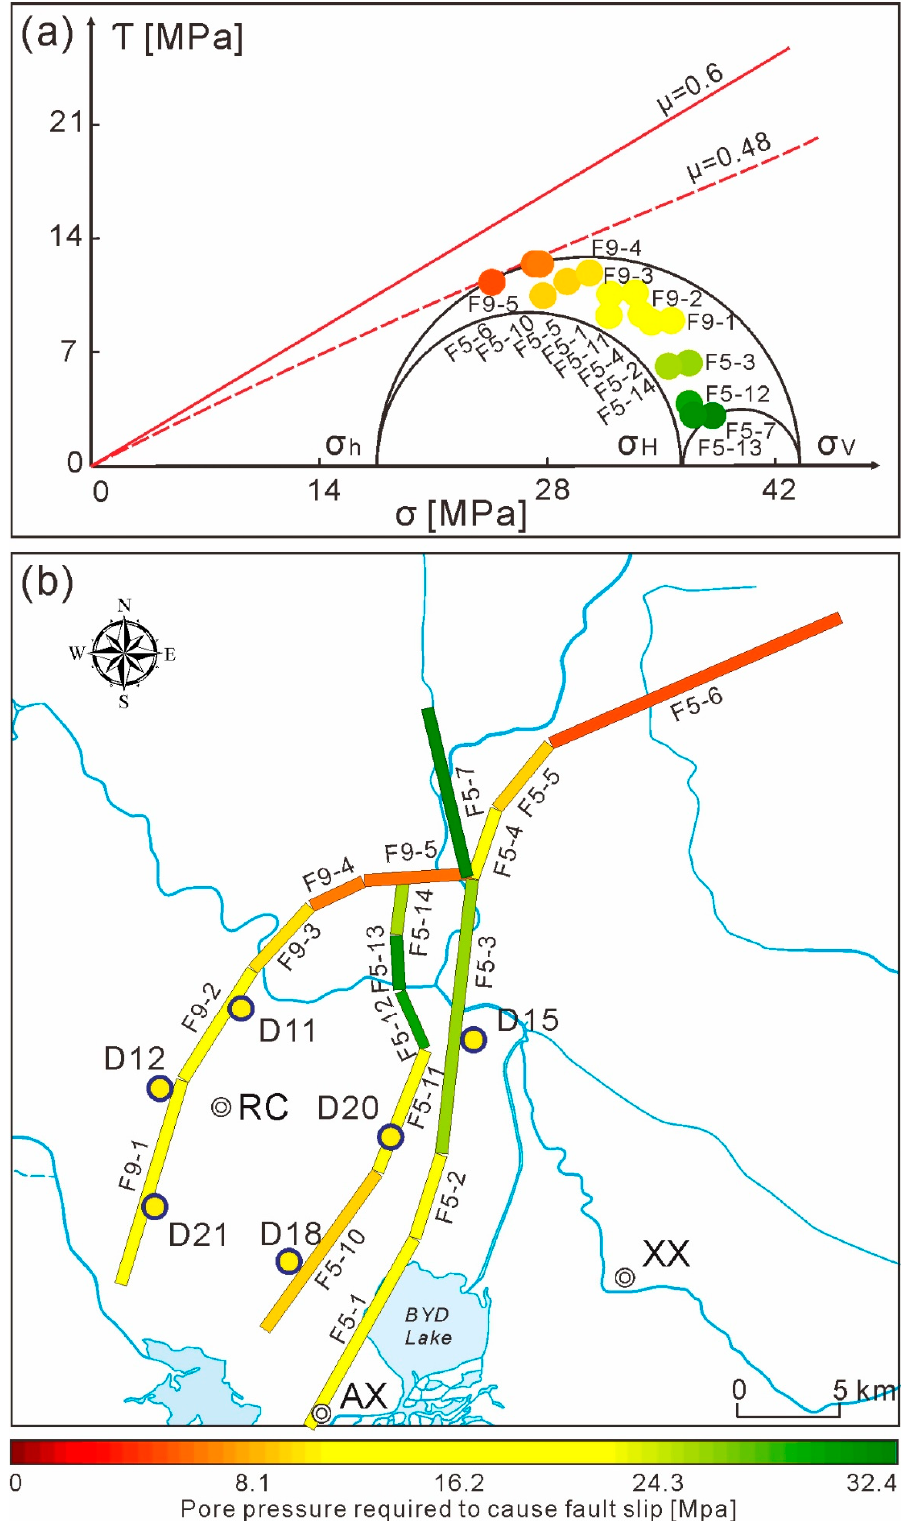
Figure 4. The initial stability of the main active faults in the Rongcheng deep geothermal reservoir area at a reference depth of 2600 m. ( a ) A Mohr diagram of the active fault segments, where the horizontal axis is the effective compressive stress and the vertical axis is the shear stress. The color of the dots represents the critical pore pressure required to produce a fault slip. ( b ) Map view of the deterministic pore pressure along the fault segments. The color scheme is the same as that of panel ( a